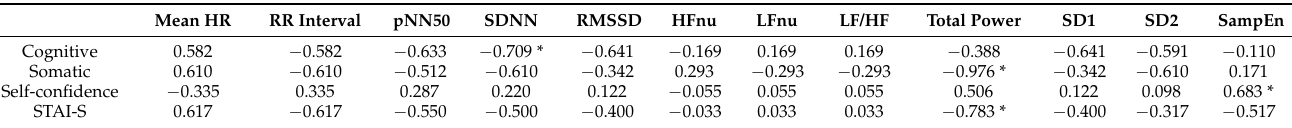
Table 4. Correlation between HRV and precompetitive values before the first match.